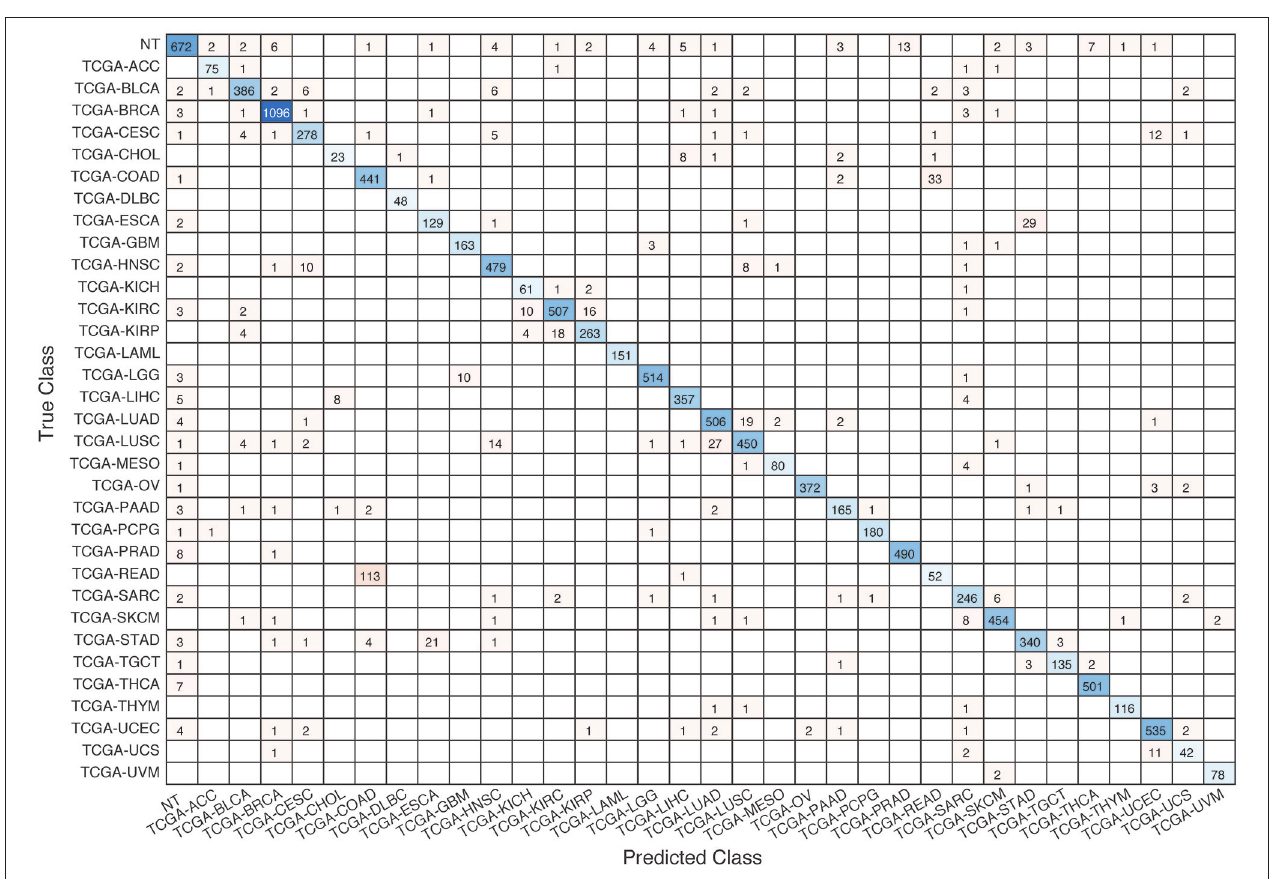
FIGURE 7 | Confusion matrix of all samples predicted by the co-expression GCNN model with combined 33 different cancer types and normal